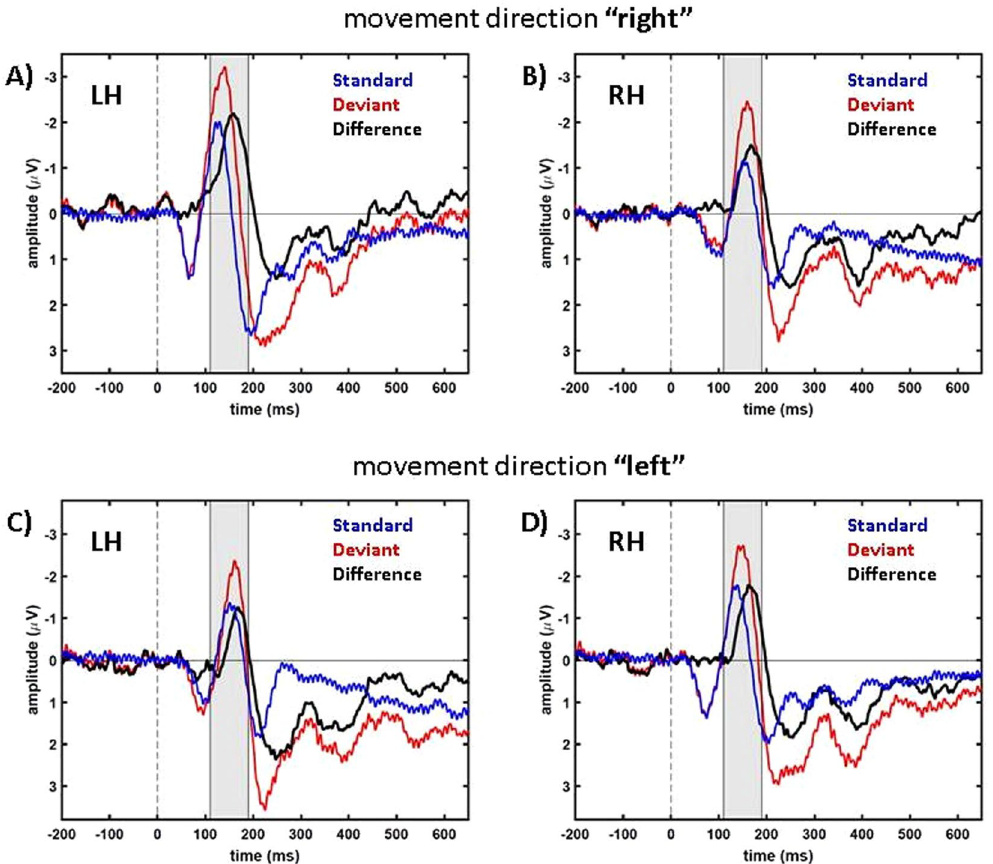
Figure 2. Average time courses of parieto-occipital electrodes in the “central” condition. In blue, data of standard trials are presented, in red, data of deviant trials, and in black the differences (standard data subtracted from deviant data). ( A , B ) show the condition “right” (i.e. target reappearance in the right visual hemifield) and ( C , D ) the condition “left” (reappearance in the left visual hemifield). In ( A , C ) data show averages across the electrode cluster LH (P3, P7 and PO3). Accordingly, in ( B , D ) data show averages from electrode cluster RH (P4, P8 and PO4). Thus, panels (A,D) show signals contralateral to the side of the target’s reappearance while panels (B,C) show signals for ipsilateral reappearance. The gray areas mark the time window shown in Fig.